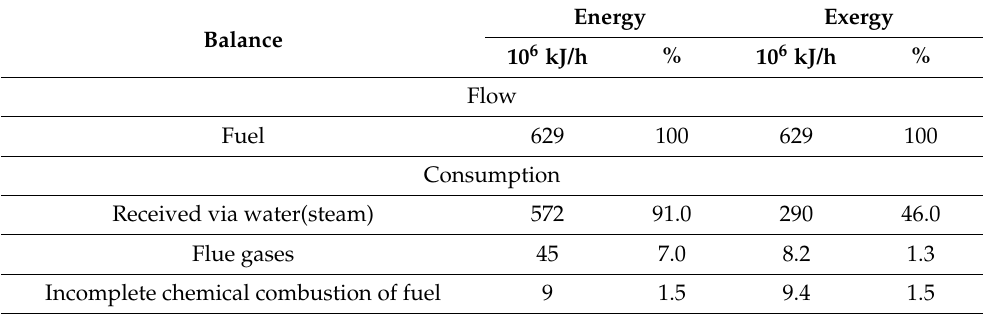
Table 2. Comparative total energy and exergy balances of the boiler unit for all